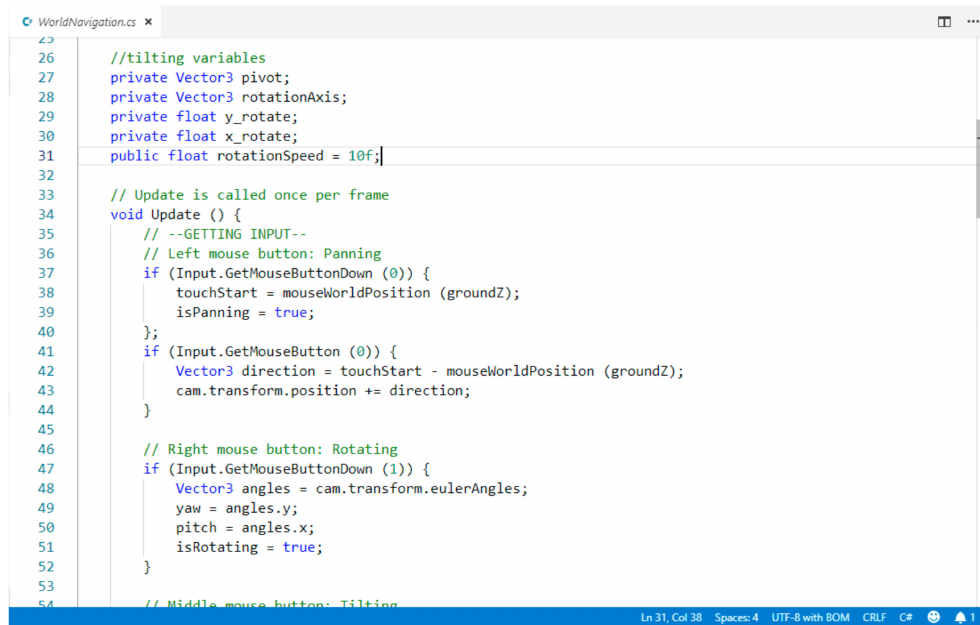
Figure 8. Sample C# script for handling mouse